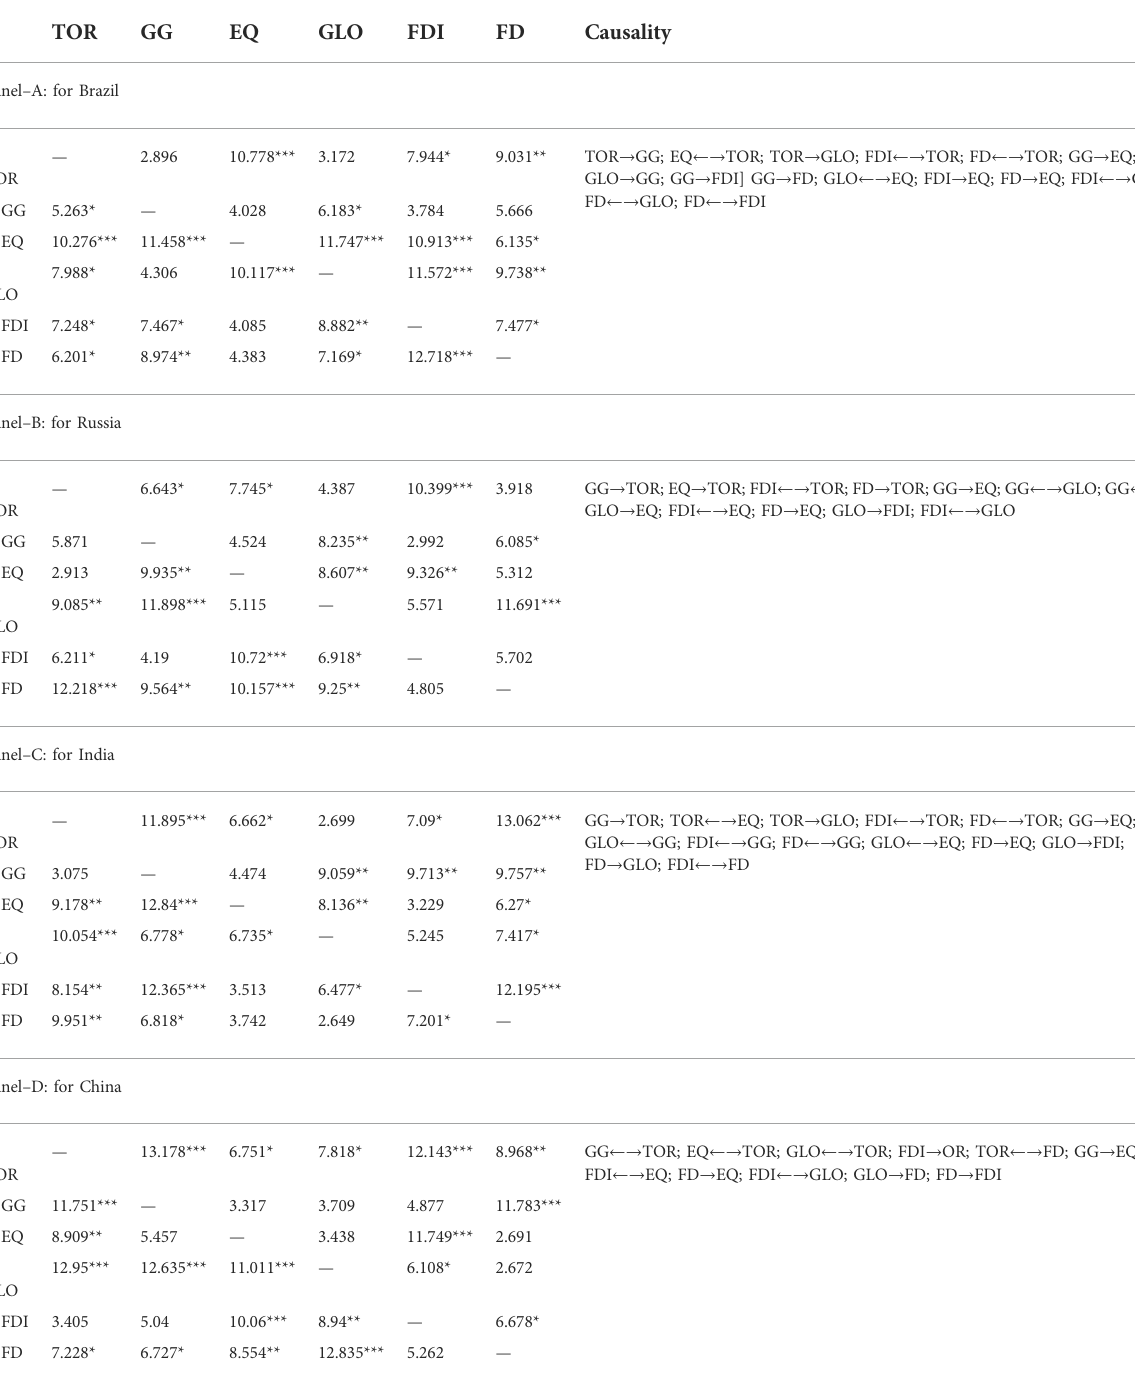
TABLE 8 Toda – Yamamoto causality test (k =